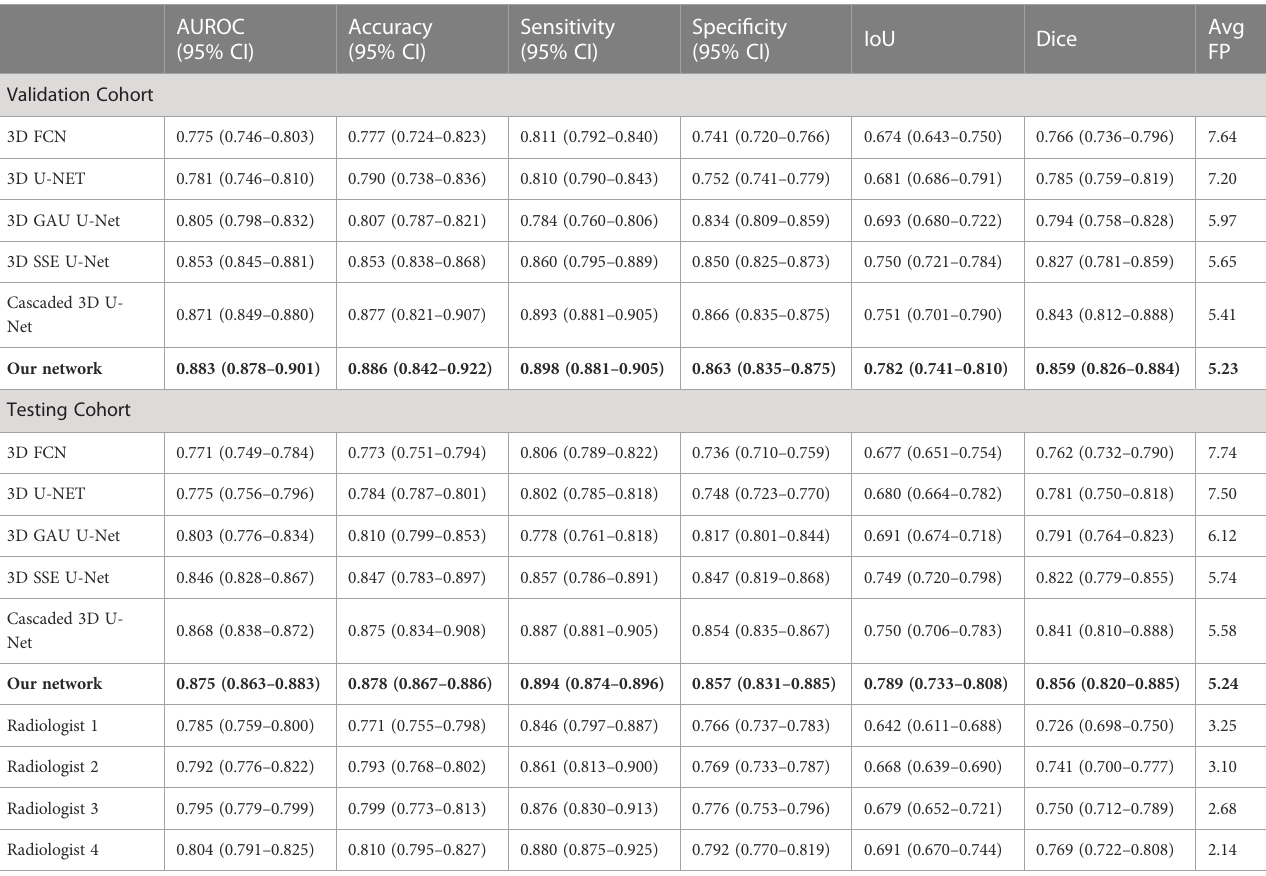
TABLE 2 Results of comparison with other networks and fi ve radiologists on the testing